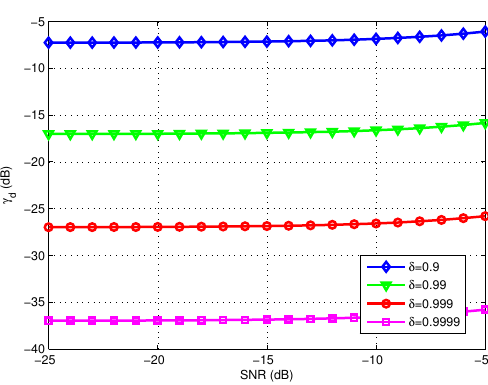
Figure 4. The effect of the number of training symbols on the NLD residual